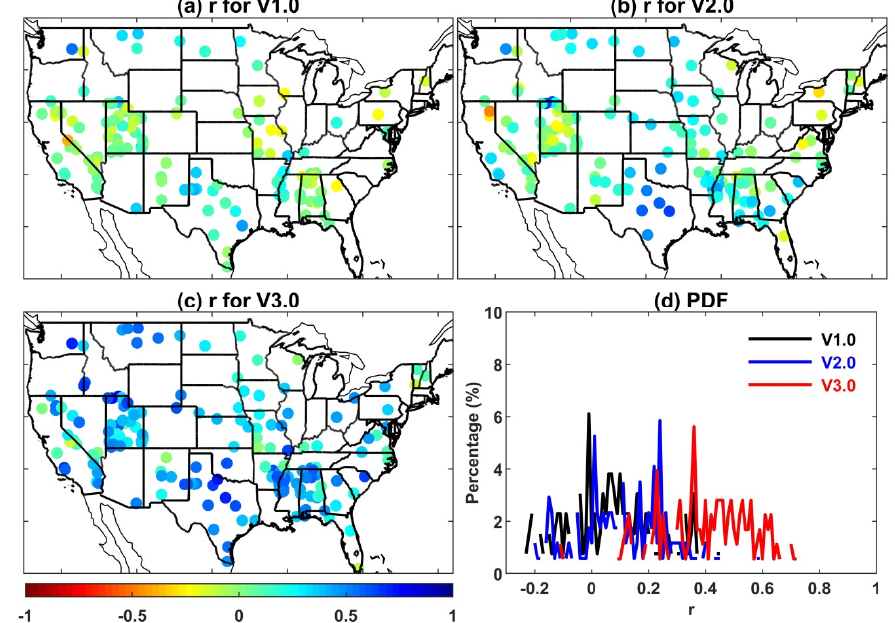
Figure 3. With respect to the quality controlled soil climate analysis network (SCAN) observations, correlation coefficients ( r ) for ( a ) SMOPS version 1.0 over the 1 June 2007–3 November 2011 period, ( b ) SMOPS version 2.0 over the 16 November 2011–20 September 2016 period, ( c ) SMOPS version 3.0 over the 1 April 2015–31 December 2019 period, as well as ( d ) contiguous United States (CONUS) domain-averaged frequency probability as a function of correlation coefficients for the three versions SMOPS blended soil moisture data products during the corresponding product time periods with curves shifting toward the right (left) indicating stronger (weaker) correlations.